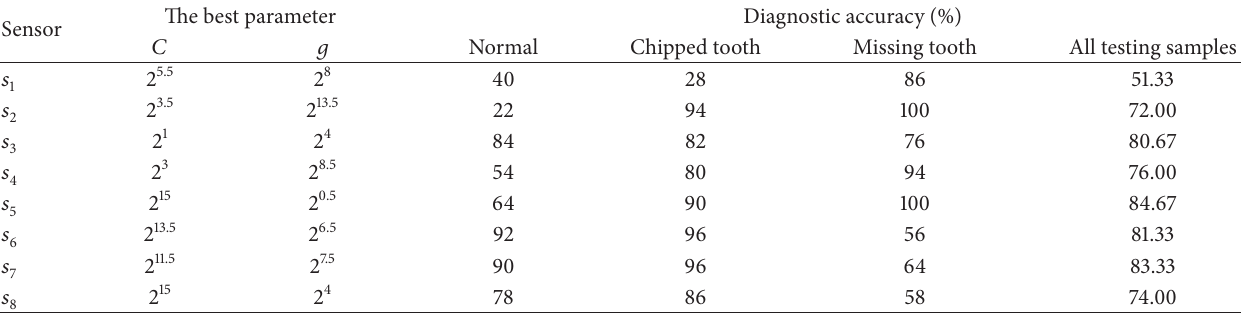
Table 3: Diagnostic results of gear by using different single